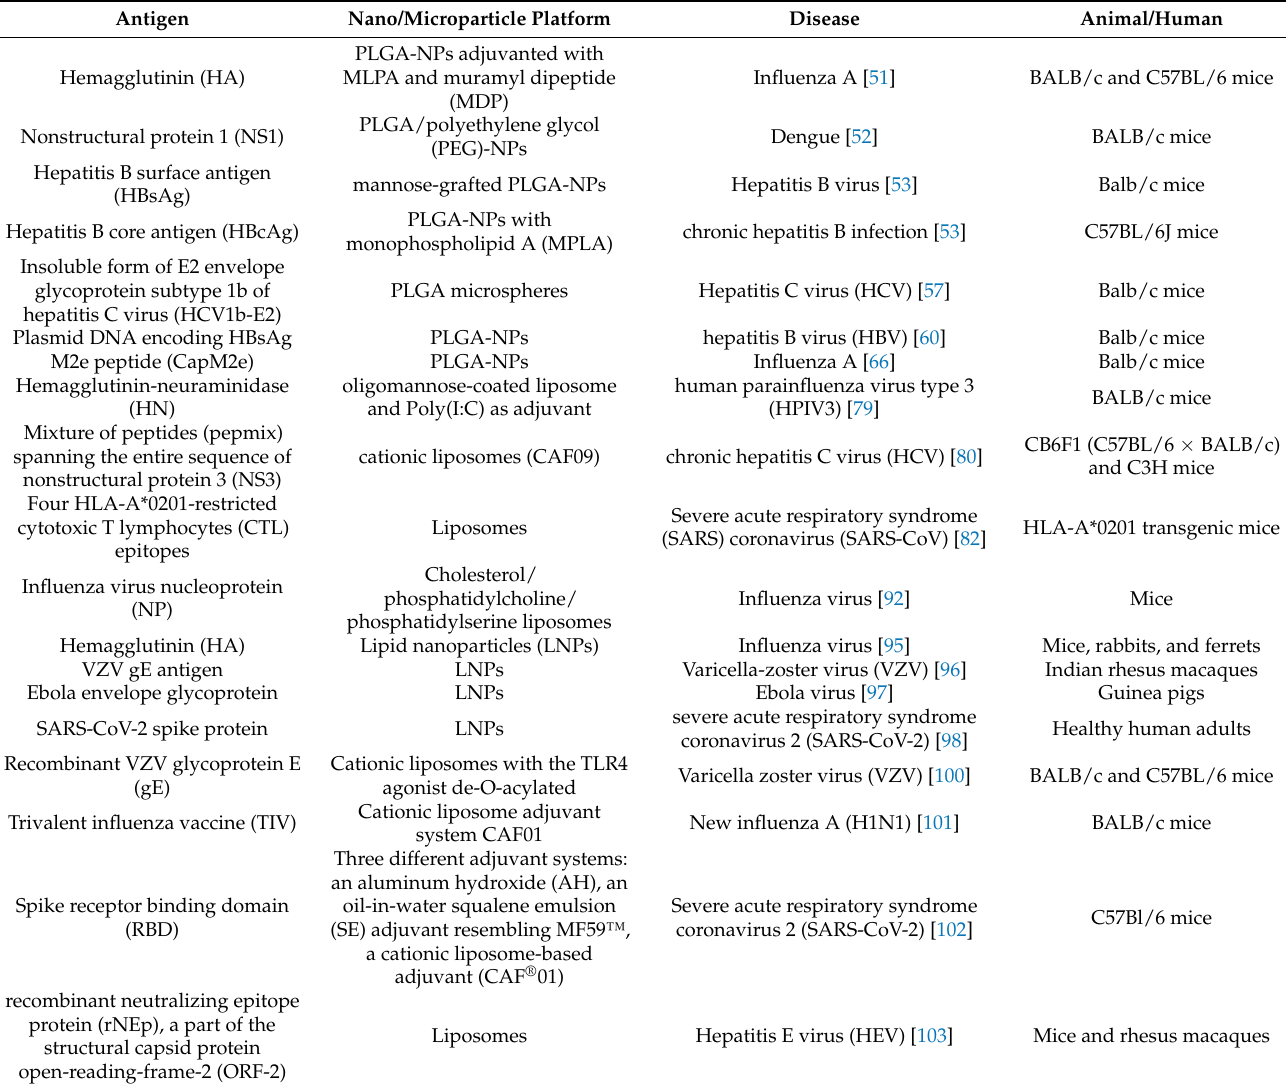
Table 1. List of advanced vaccines delivered by nano- and microcarriers for the treatment of viral